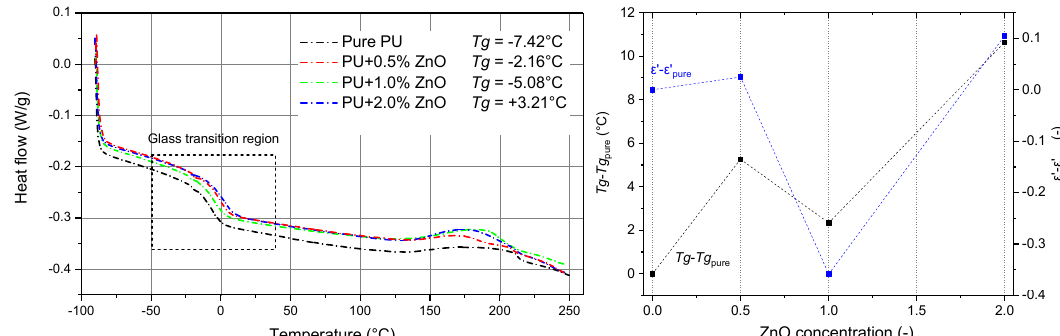
Figure 2. DSC diagrams with determined glass transient temperatures and their changes compared with changes of the real part of complex